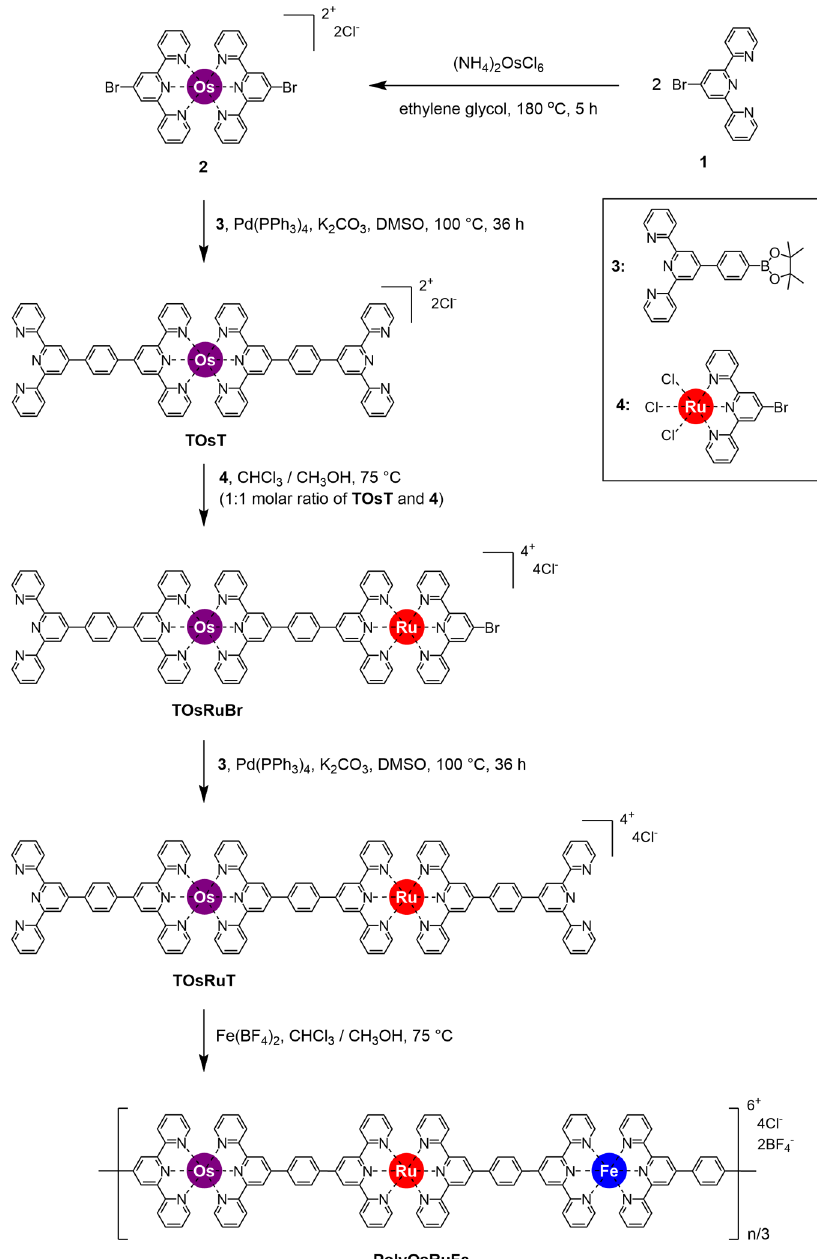
Fig. 1 Synthesis and chemical structure of polyOsRuFe. The stepwise synthesis of